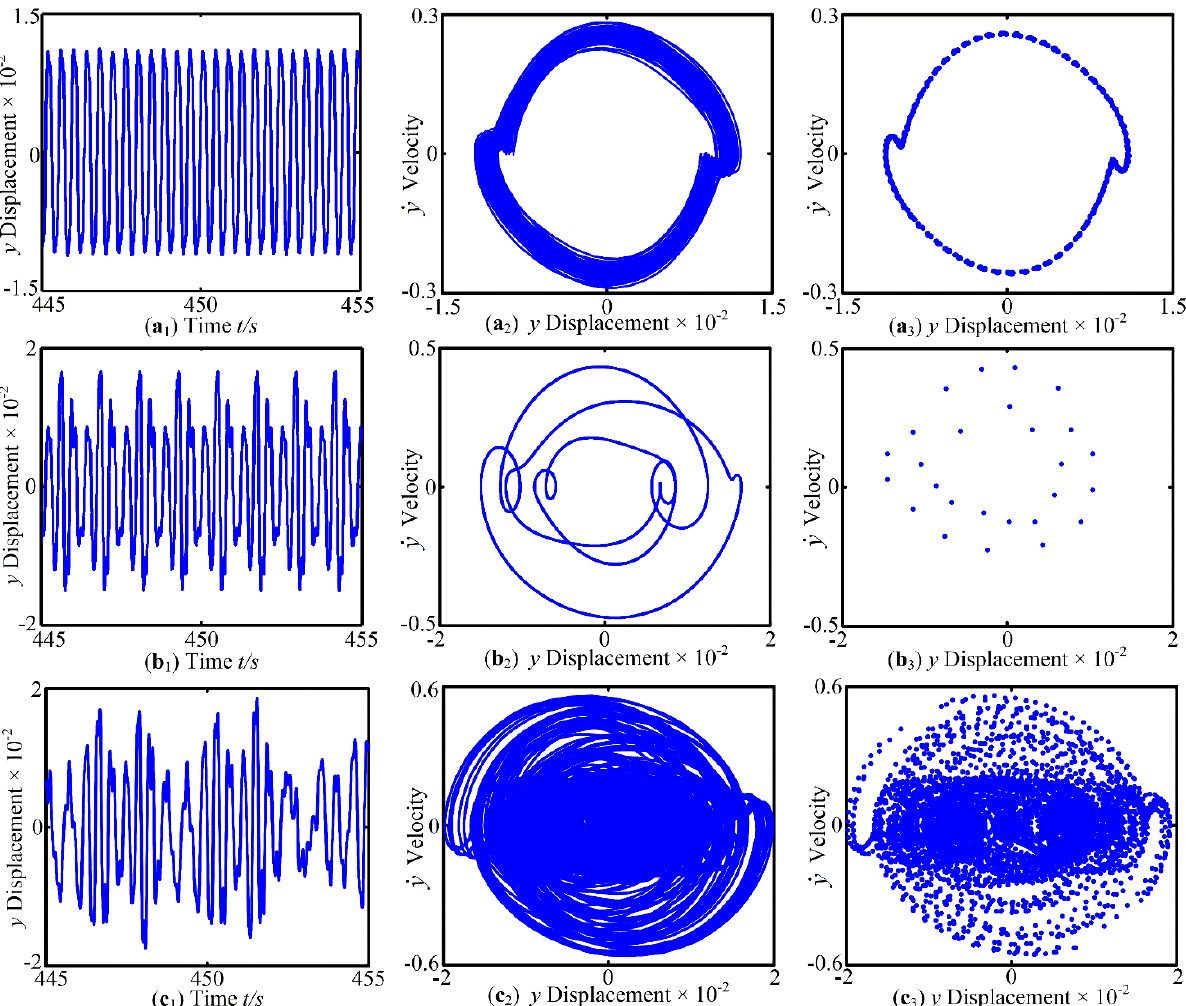
Figure 11. Waveform (1), phase diagram (2) and Poincaré map (3) with u 0 = 3.384 quasi-periodic motion ( a ), u 0 = 4.018 periodic motion ( b ), u 0 = 4.386 chaotic motion ( c ).